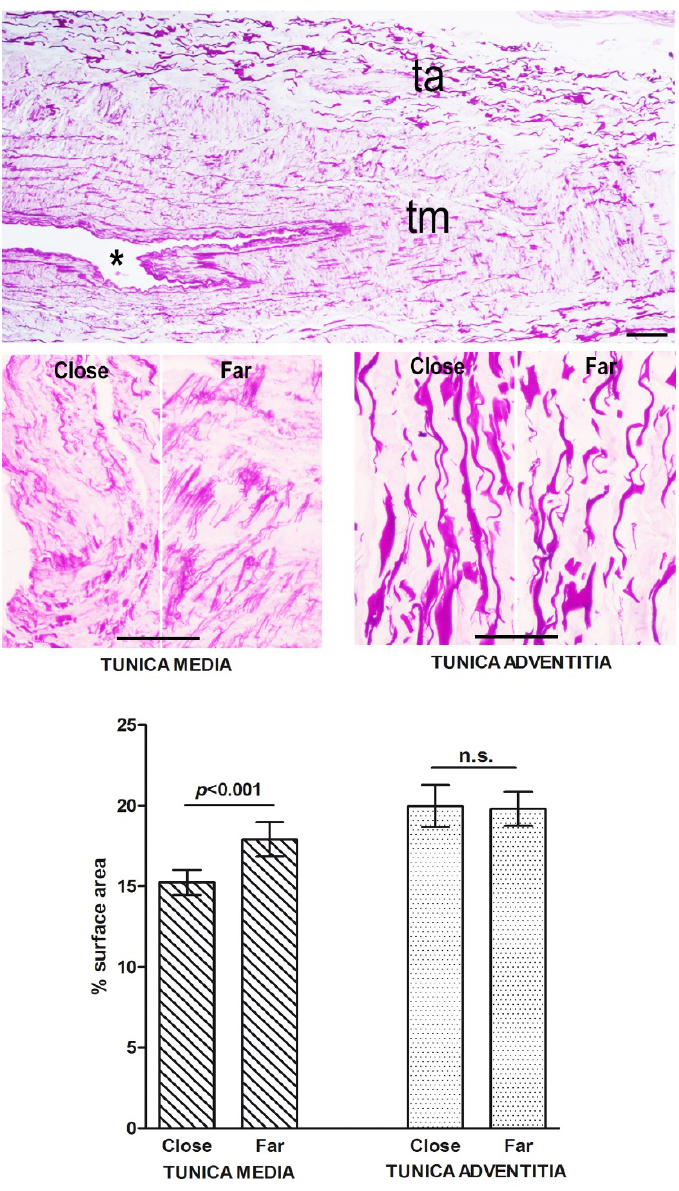
Figure 7. Light microscopic appearance and morphometry of elastic fibers from vein wall areas located close to and far from (3–5 mm) the surgical wound. No substantial differences can be seen or measured in the tunica adventitia (ta), whereas in the tunica media (tm) the elastic fiber meshwork is slightly, albeit significantly, reduced in proximity to the wound. * lumen. PAF staining; bars = 100 µm; values are mean ± s.e.m., n = 4, n.s. not significant.